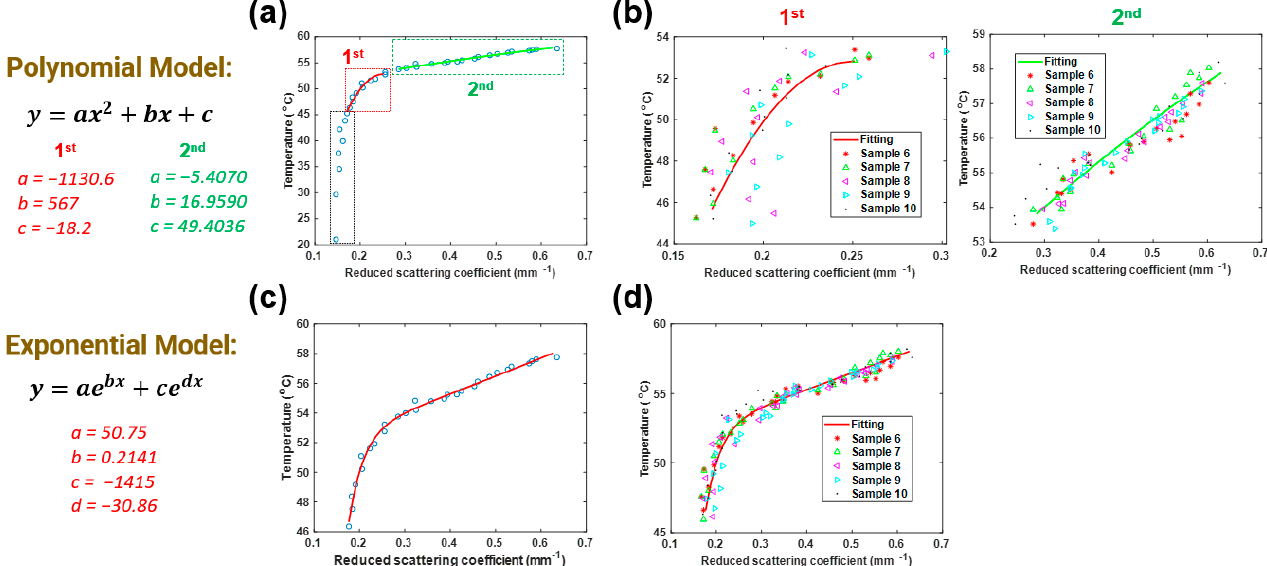
Figure 5. Fitting ( a ) polynomial model and ( c ) exponential model to measured DOT data of chicken breast muscle tissues. Comparison between the temperatures calculated/predicted by ( b ) polynomial and ( d ) exponential methods (solid line) and those measured by a thermometer (scattered points) as a function of µ (cid:48) s